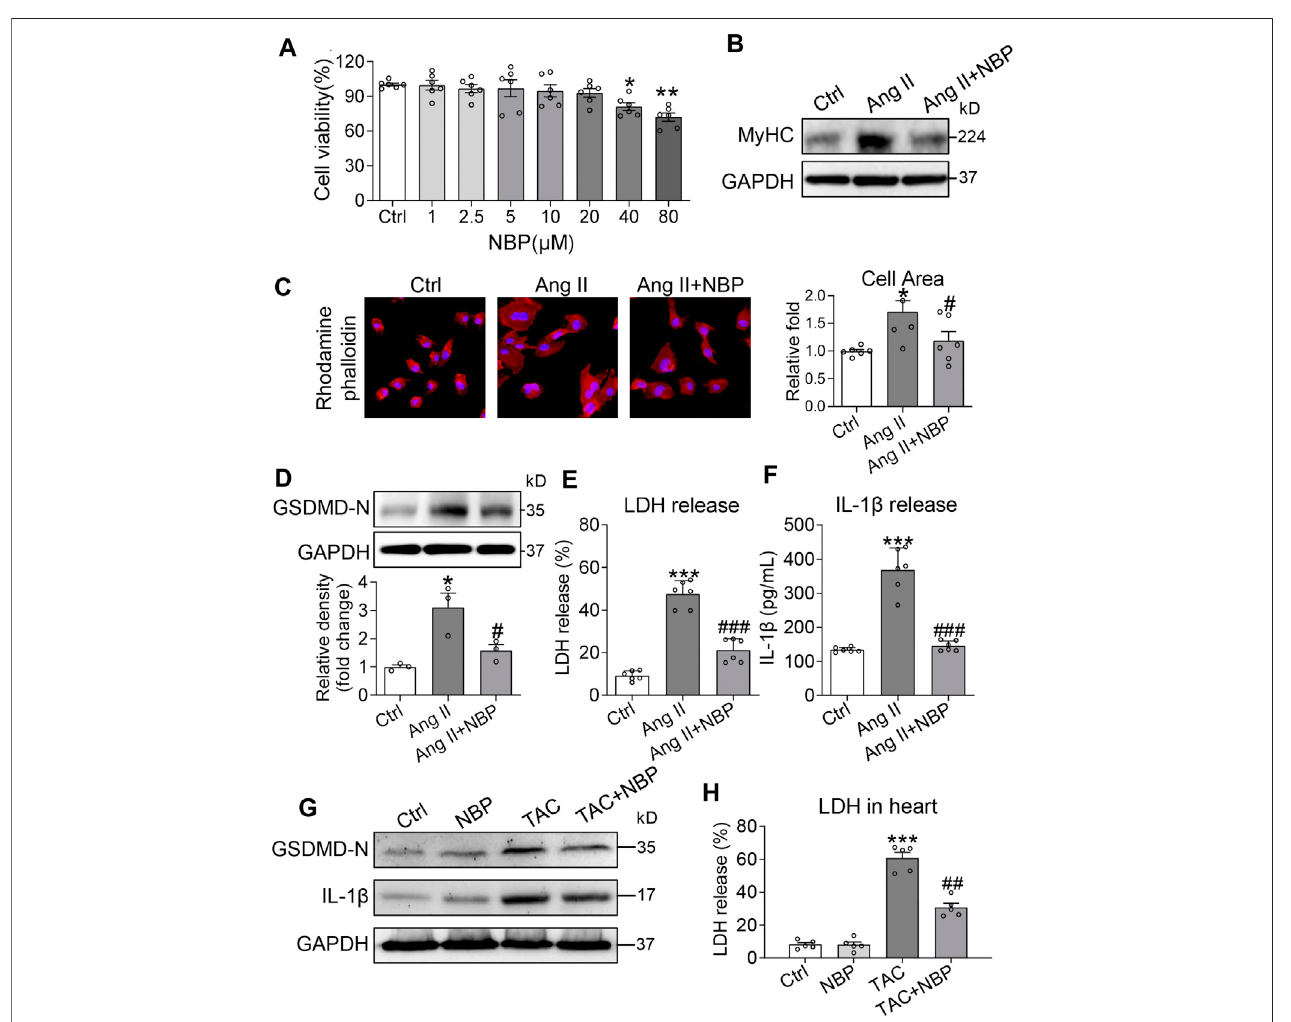
FIGURE 3 | NBPalleviatesAngII-induced cardiomyocyte hypertrophy and GSDMD-mediated in fl ammation. (A) Primary cardiomyocytes werecultured in the presence of theindicatedconcentrationsofNBPfor72 handthenmeasuredforcellviabilitybyCCK-8assays.DMSOwasusedasthecontrol.Primarycardiomyocyteswerepretreatedwith NBP(20 μ m)for1 handthenstimulatedwith1 μ mAngIIfortheindicatedtimes. (B) AfterexposuretoAngIIfor24 h,celllysateswereprobedfor β -MyHCbywesternblotanalysis. GAPDH was used as the loading control. (C) Rhodamine phalloidin staining of primary cardiomyocytes showing the effect of NBP on Ang II-induced hypertrophy (DAPI: nucleus; × 400 magni fi cation). Quanti fi cation of the cell size is shown in the right panel. (D) Western blotting analysis of GSDMD in primary cardiomyocytes. The densitometric analysisisshowninthelowerpanel. (E – F) ExposuretoAngIIfor24 hshowingtheLDHandIL-1 β releasefromtheprimarycardiomyocytes.[ A,C,E,F ,n (cid:1) 6; (D) ,n (cid:1) 3;*,vs.Ctrl group;#,vs.AngIIgroup;*and# p < 0.05,** p < 0.01,***and### p < 0.001] (G) WesternblottinganalysisofIL-1 β andGSDMDinhearttissues. (H) LDHcontentinTACmiceand mice treated with NBP (n (cid:1) 5 in each group; *, vs. Ctrl group; #, vs. TAC group; ## p < 0.01, *** p <